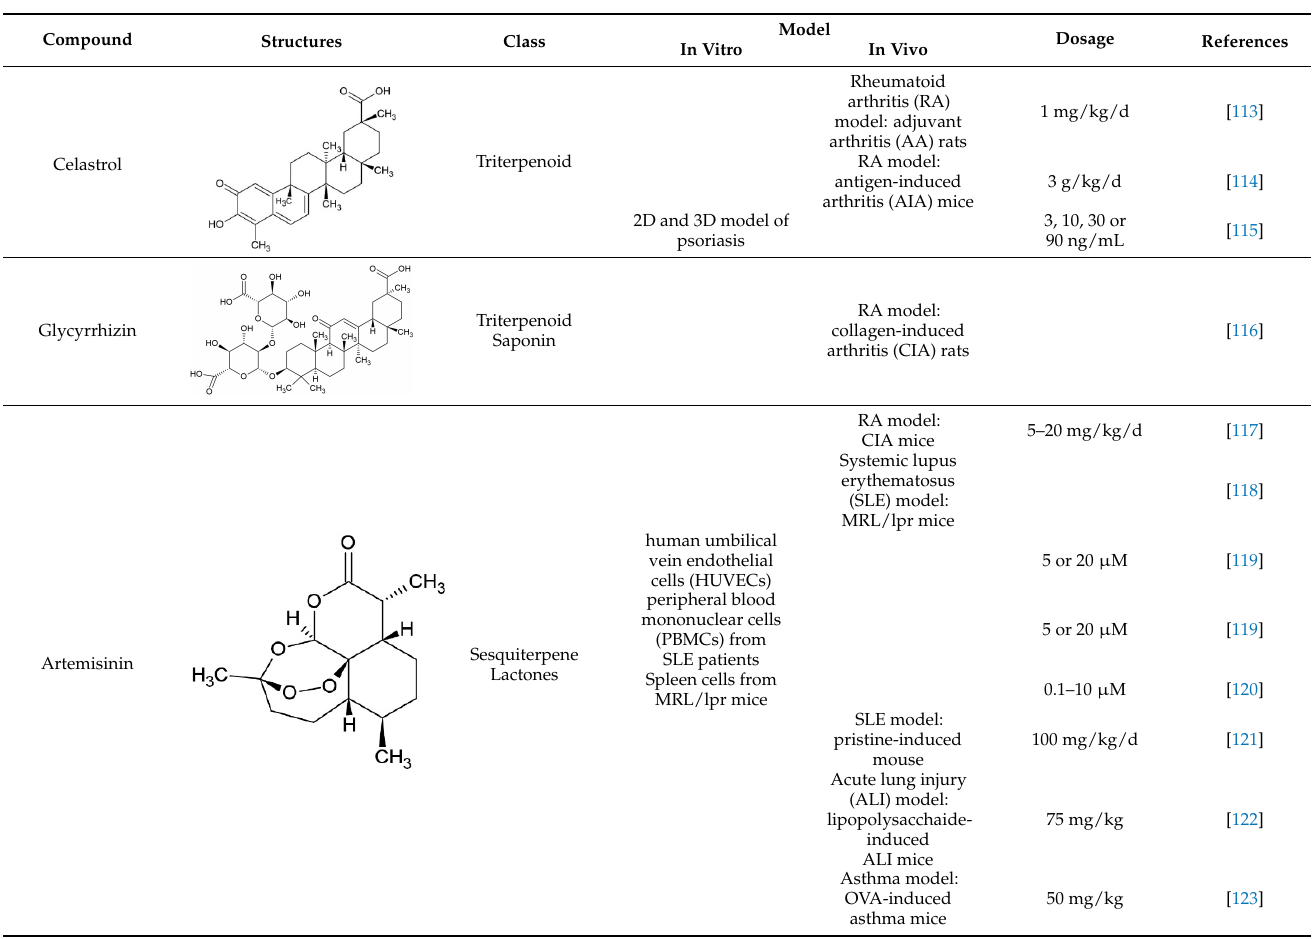
Table 2. Natural products tested in animal models of autoimmune diseases.